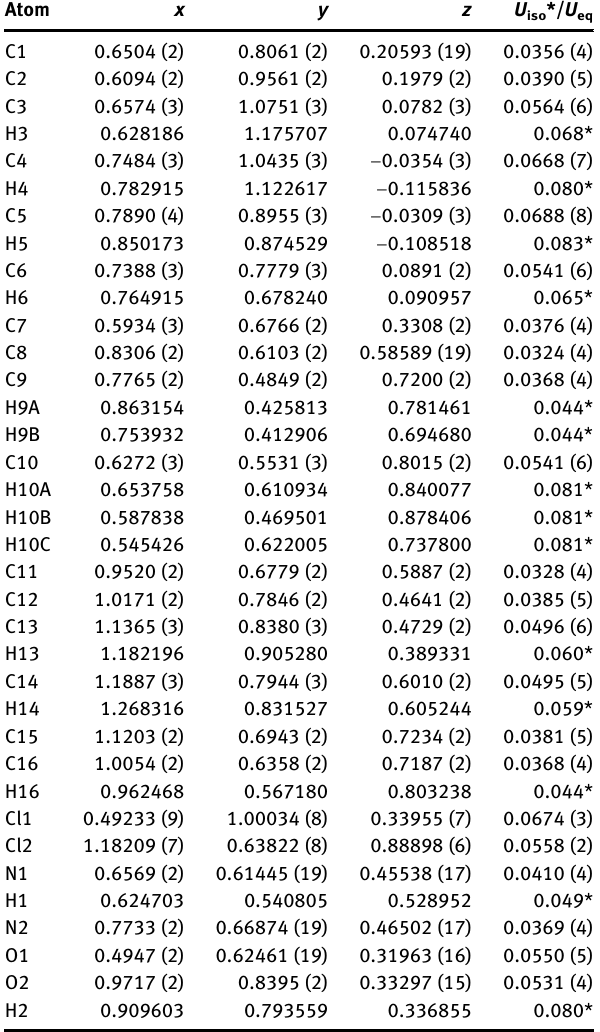
Table  : Fractional atomic coordinates and isotropic or equivalent isotropic displacement parameters (Å 